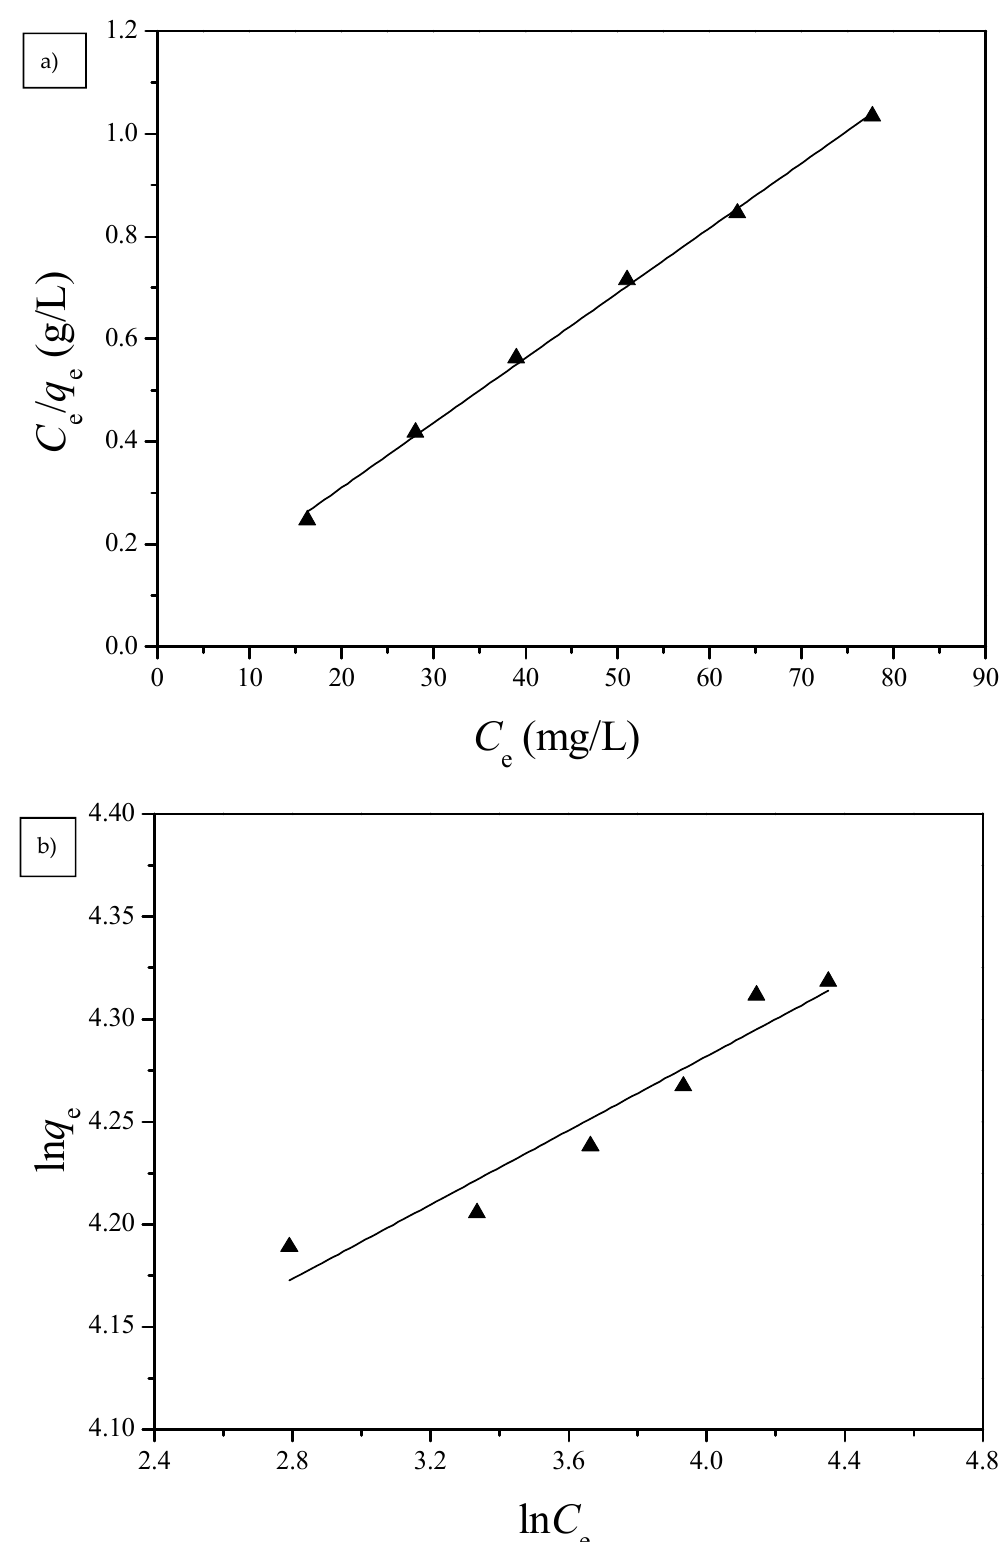
Figure 10. ( a ) Langmuir and ( b ) Freundlich isotherms for the adsorption of Cu(II) by G1H20 nanoparticles at a pH of 6 and 60 °C. Table 2. Langmuir and Freundlich isotherm constants for Cu(II) adsorption onto G1H20 nanopar- ticles at a pH of 6 and 60 °C.